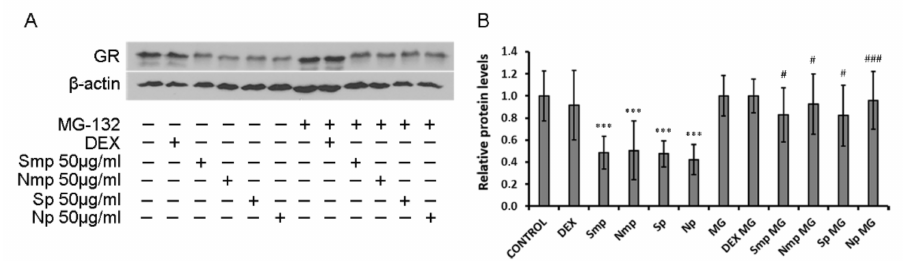
Figure 4. Activation of GR proteolytic degradation by leaves fractions. ( A ) Western blot analysis of GR was performed using commercially provided antibodies to evaluate GR and β -actin protein levels in HEK293 cell extracts pre-treated with 5 µ M MG-132 for 1 h, and subsequently treated with vehicle or 50 µ g/mL leaves fractions or 10 nM DEX, for 24 h in hormone depleted medium. ( B ) Quantification of the results. GR protein levels were normalized against the respective β -actin protein levels. Data are expressed as the mean ± SD, ( n = 3), *** p < 0.001, compared to control vehicle-treated cells. ### p < 0.001, # p < 0.05 compared to the respective MG-132-treated